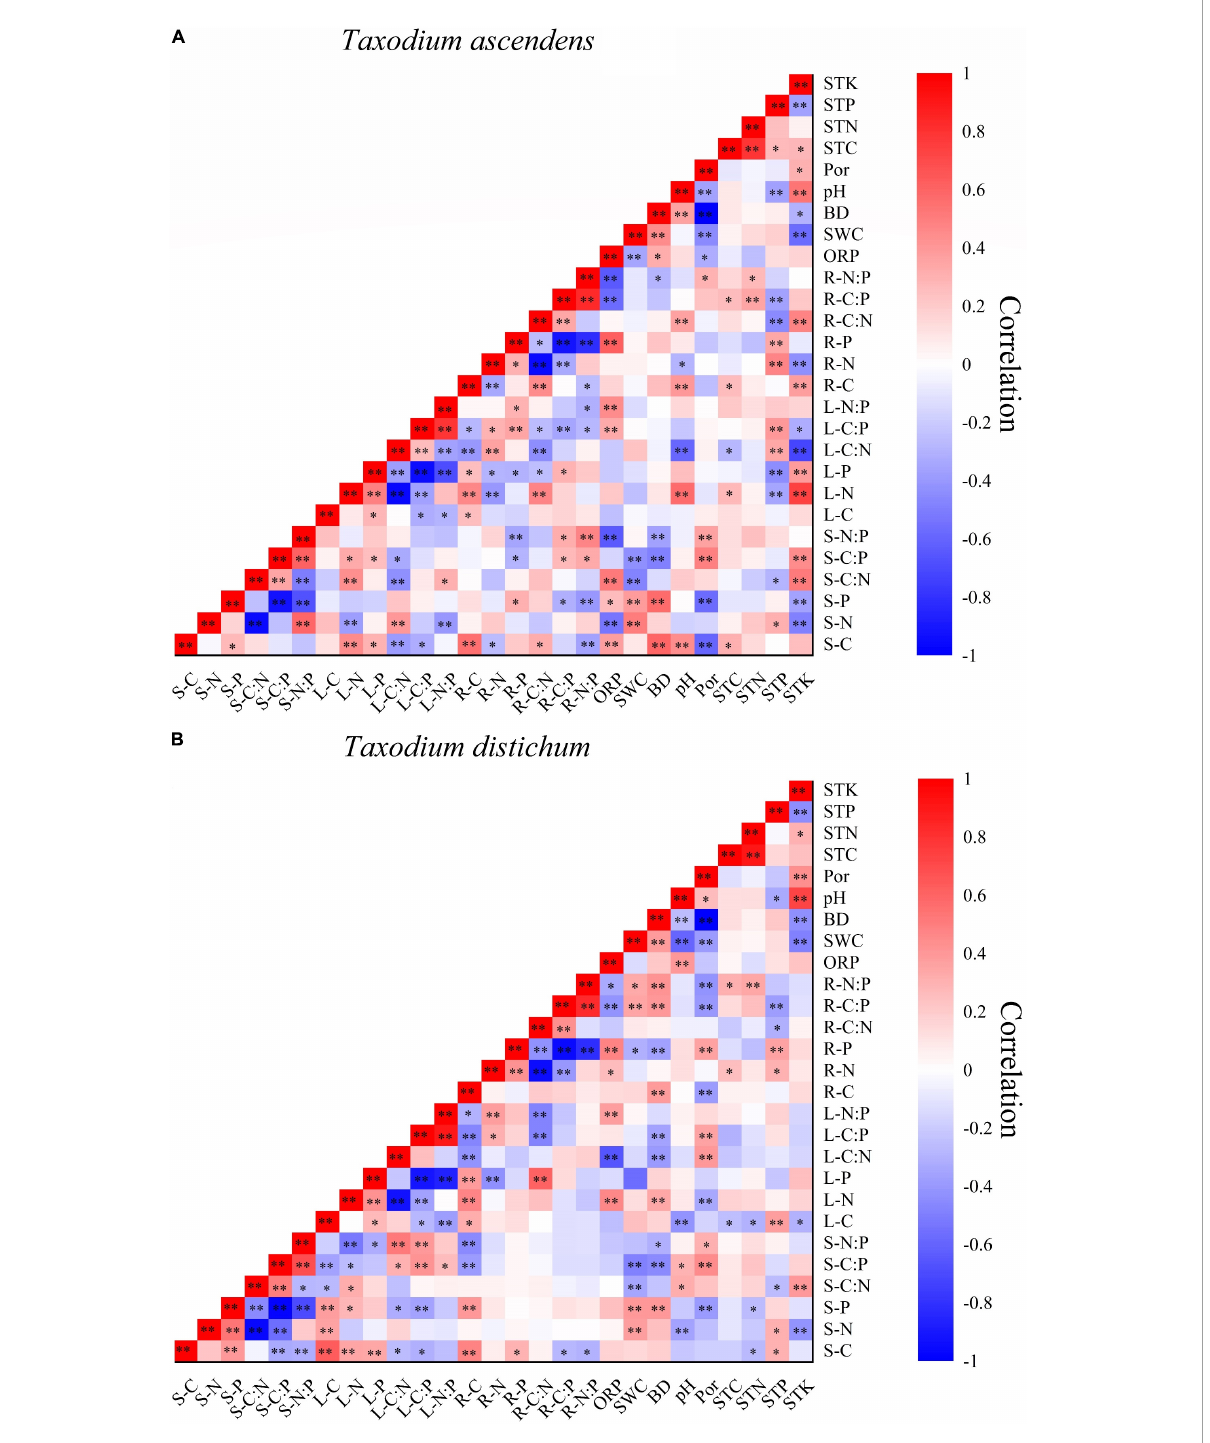
FIGURE9 Heat maps of Pearson’s correlation among the C, N, and P concentrations and stoichiometry in various plant parts and soil factors of T. ascendens (A) and T. distichum (B) . S-C, stem carbon; S-N, stem nitrogen; S-P, stem phosphorus; S-C:N, stem C:N ratio; S-C:P , stem C:P ratio; S-N:P , stem N:P ratio; L-C, leaf carbon; L-N, leaf nitrogen; L-P, leaf phosphorus; L-C:N, leaf C:N ratio; L-C:P , leaf C:P ratio; L-N:P , leaf N:P ratios; R-C, fine root carbon; R-N, fine root nitrogen; R-P, fine root phosphorus; R-C:N, fine root C:N ratio; R-C:P, fine root C:P ratio; R-C:P, fine root N:P ratio; ORP, soil oxidation-reduction potential; SWC, soil water content; BD, soil bulk density; pH, soil pH value; Por, soil porosity; STC, soil total carbon; STN, soil total nitrogen; STP, soil total phosphorus; STK, soil total kalium. ** Correlation is significant at the 0.01 level (two-tailed); * Correlation is significant at the 0.05 level